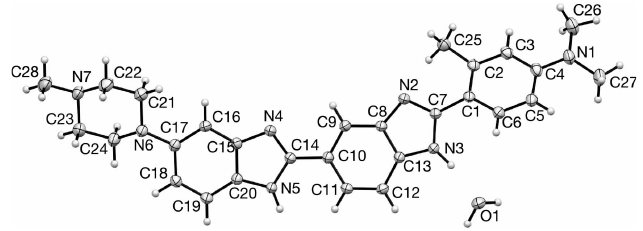
Figure 2 Displacement ellipsoid plot of the asymmetric unit for hydrate (1) (cid:2) H 2 O.